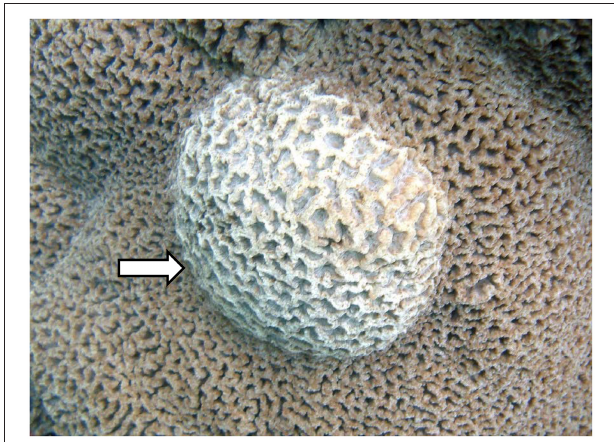
FIGURE 1 | Picture of Platgyra carnosus skeletal growth anomaly (SGA) as indicated by an arrow and normal tissue on the remaining